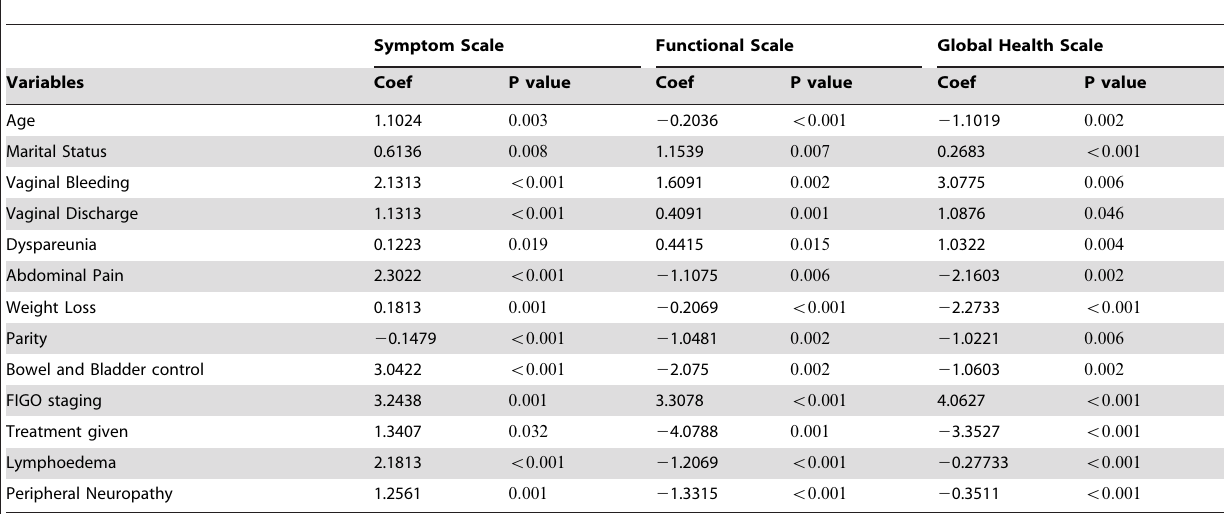
Table 4. Coefficients(coef) of significant variables for Symptom scale, Functional scale and Global health/Quality of Life (GH/QoL) post treatment in Logistic Regression model, a Generalized linear model (GLM)